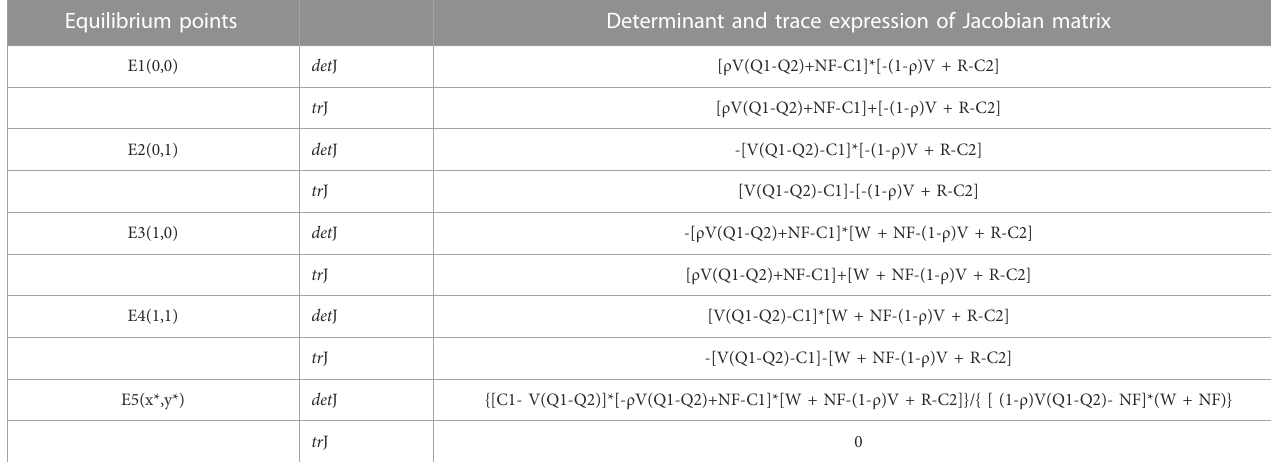
TABLE 2 detJ and trJ of equilibrium points of evolutionary game model between local government and coal mining enterprises. Equilibrium points Determinant and trace expression of Jacobian matrix